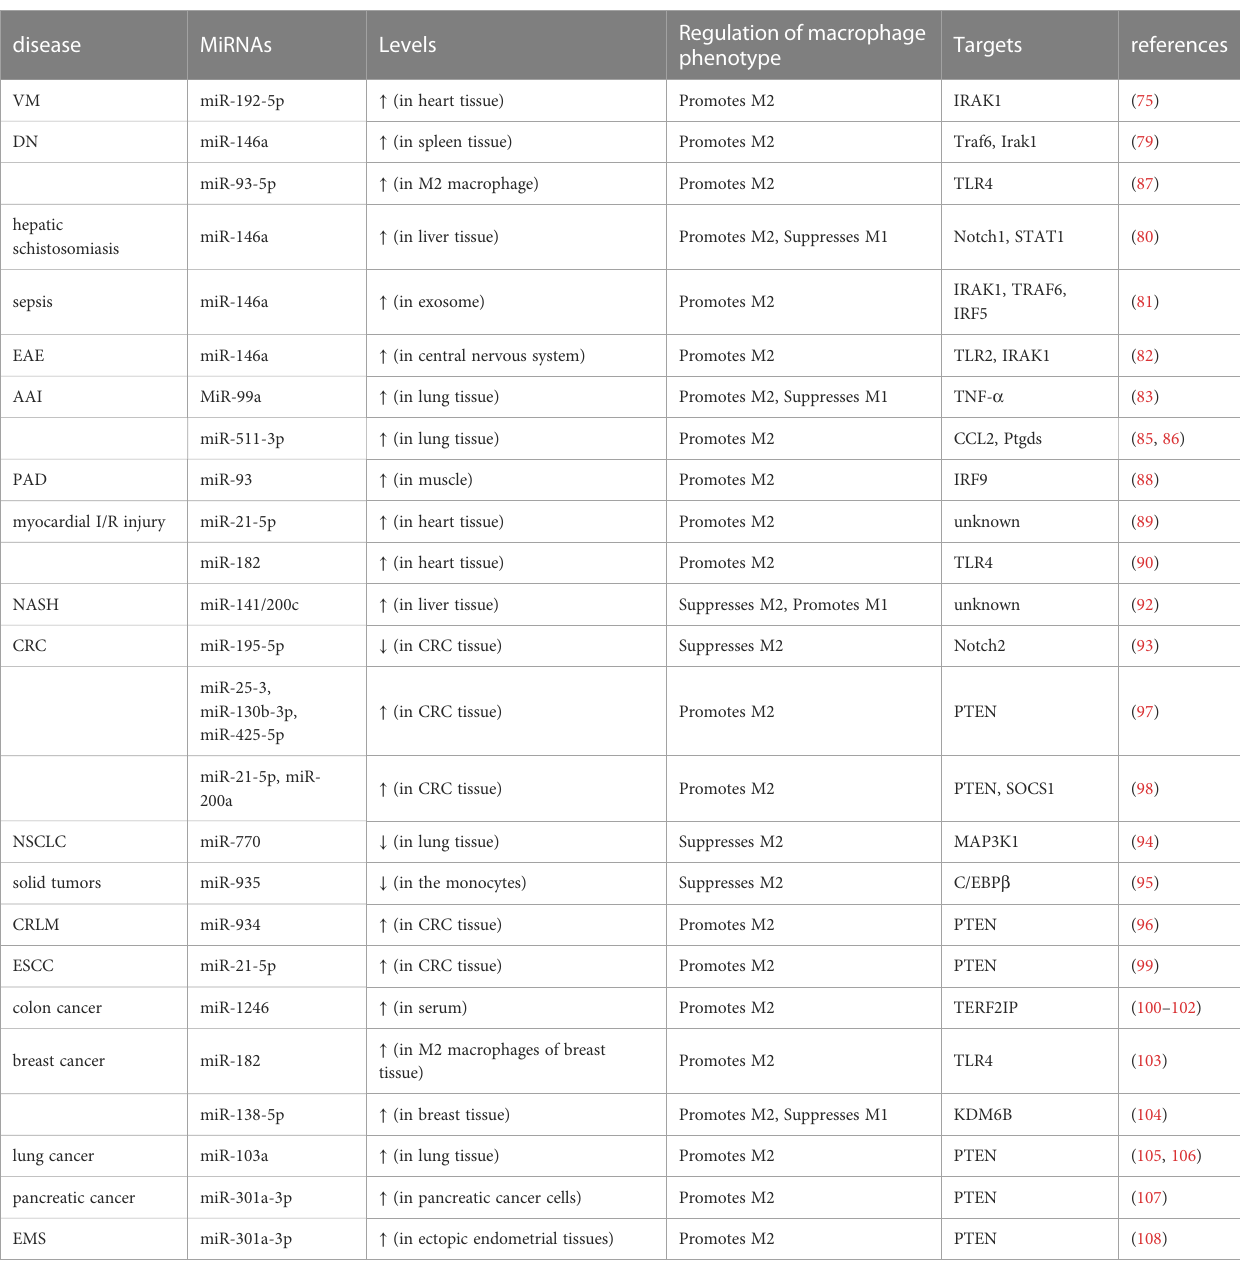
TABLE 2 M2 macrophage polarization by miRNAs in various diseases.